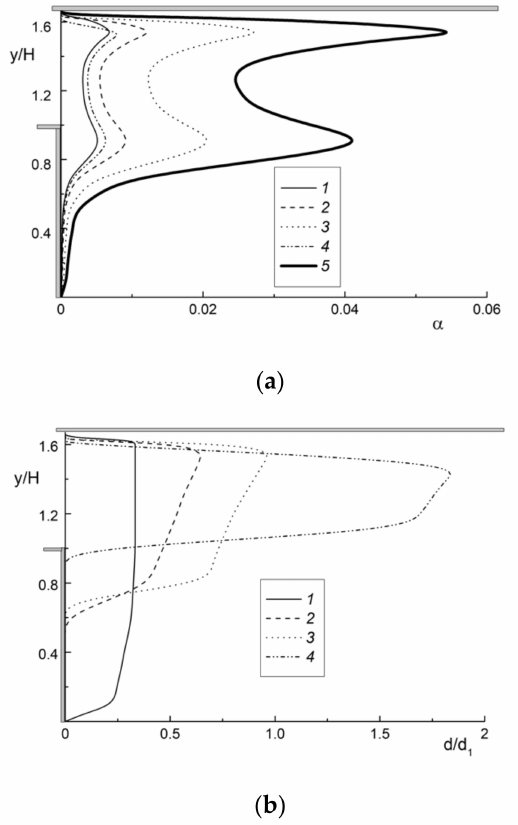
Figure 11. The transverse profiles of local void fractions ( a ) and bubble diameter ( b ) for various bubble size modes. Re H = 6600, ER = 2.5, β = 3%, x / H = 4. ( a ): 1— d / d 1 = 0–0.33, 2—0.33–0.66, 3—0.66–1, 4—>1, 5—sum of all modes; ( b ): 1— d = 0–0.33, 2—0.33–0.66, 3—0.66–1,